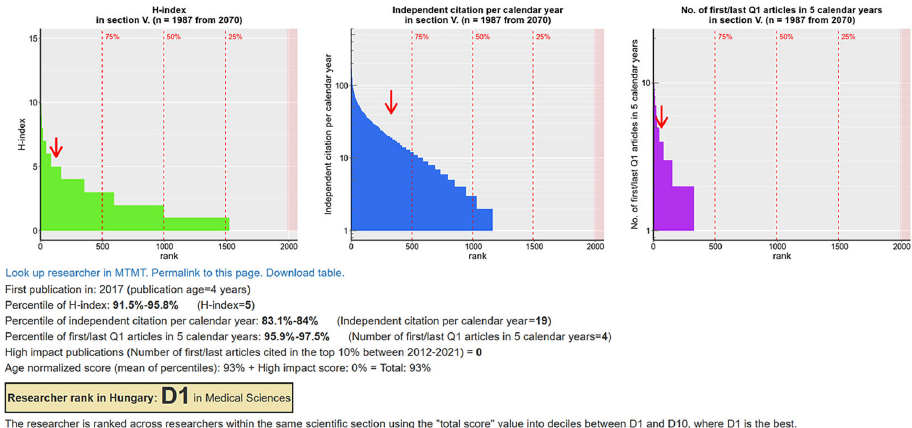
Note . The left panel shows the h-index. The central panel shows the number of independent citations per year. The right panel shows the number of first/last/corresponding authored Q1 articles in the last five years. For